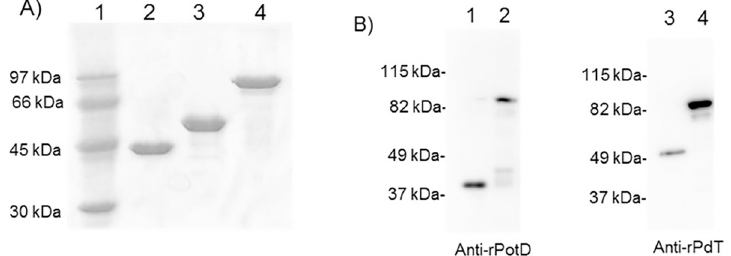
Fig 2. SDS-PAGE and western blot analysis of the purified recombinant proteins. A) SDS-PAGE of the purified recombinant proteins: 1- Molecular marker; 2- rPotD ( � 44kDa); 3- rPdT ( � 54 kDa); 4- rPotD-PdT ( � 96 kDa). B) Western blot of rPotD, rPdT or the hybrid protein. Recombinant proteins were separated by SDS-PAGE and transferred to PVDF membranes, which were incubated with anti-rPotD (left panel) or anti-rPdT (right panel): 1 – rPotD, 2 –rPotD-Pdt and anti-rPdT (right panel): 3 –rPdT, 4 –rPotD-PdT followed by incubation with anti-mouse IgG conjugated with HRP. Detection was performed with an ECL kit (GE Healthcare).